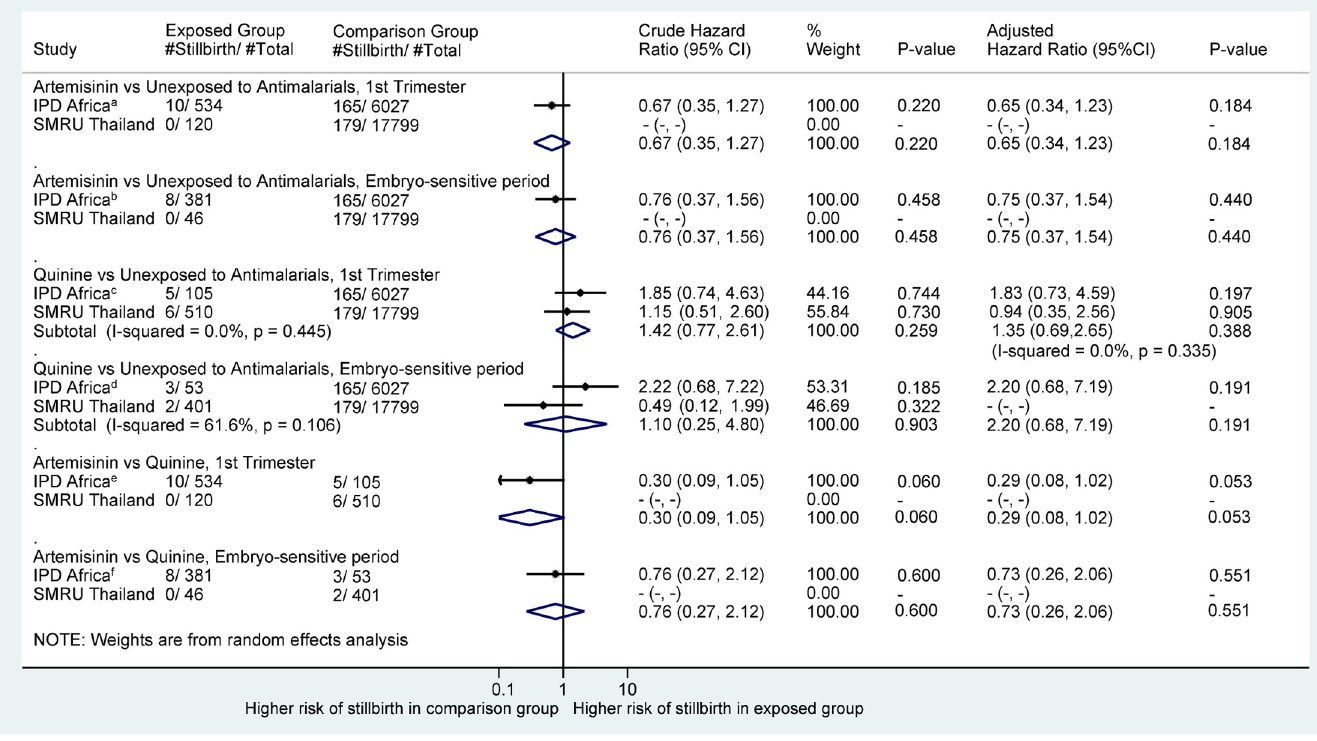
Fig 3. Forest plot for aggregated data meta-analysis of crude and adjusted hazard ratios for the association between different antimalarial exposure categories and stillbirth. HRs account for pregnancyweek under observation through left truncation and treat exposureas a time-dependent variable. I 2 values are for IPD from Africa only: a 26.0%; b 27.4%; c 26.1%; d 28.3%; e 20.5%; f 27.0%. Crude HRs are adjustedfor clusteringby site. aHRs for IPD from Africa account for site, woman’sage, and gravidity. aHRs for the SMRU account for smoking,year of first consultation, gravidity, and non-malariafebrile morbidityin the first trimester for the comparisonwith the unexposedgroup. aHR, adjusted hazardratio; HR, hazard ratio; IPD, individual patient data; SMRU, Shoklo